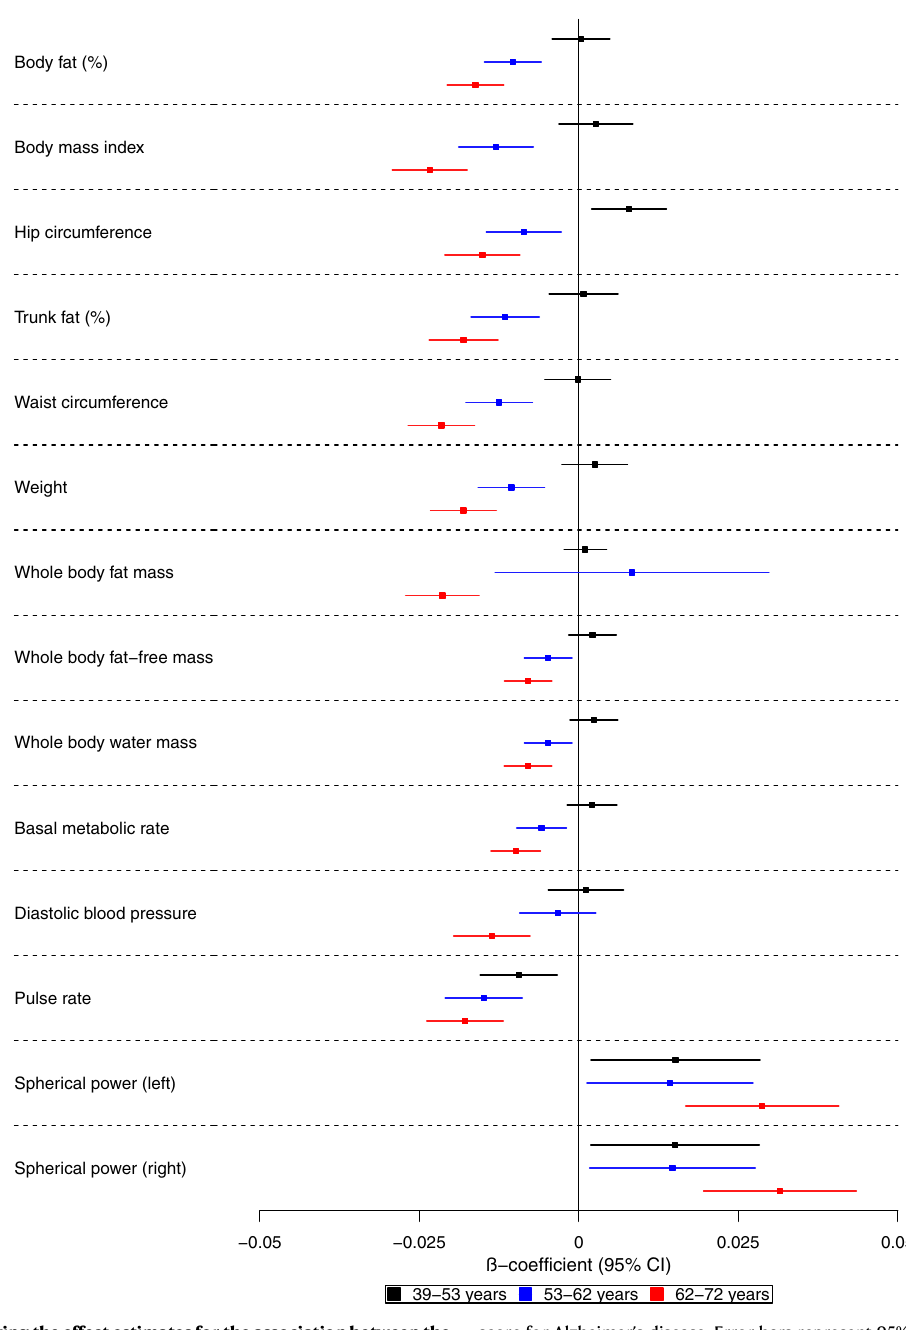
score for Alzheimer ’ s disease. Error bars represent 95% con fi dence intervals. All statistical tests were two-sided. There is evidence that the polygenic risk score for Alzheimer ’ s disease is related to physical measures in older but not younger par- ticipants. This suggests that Alzheimer ’ s disease causes these changes rather than vice